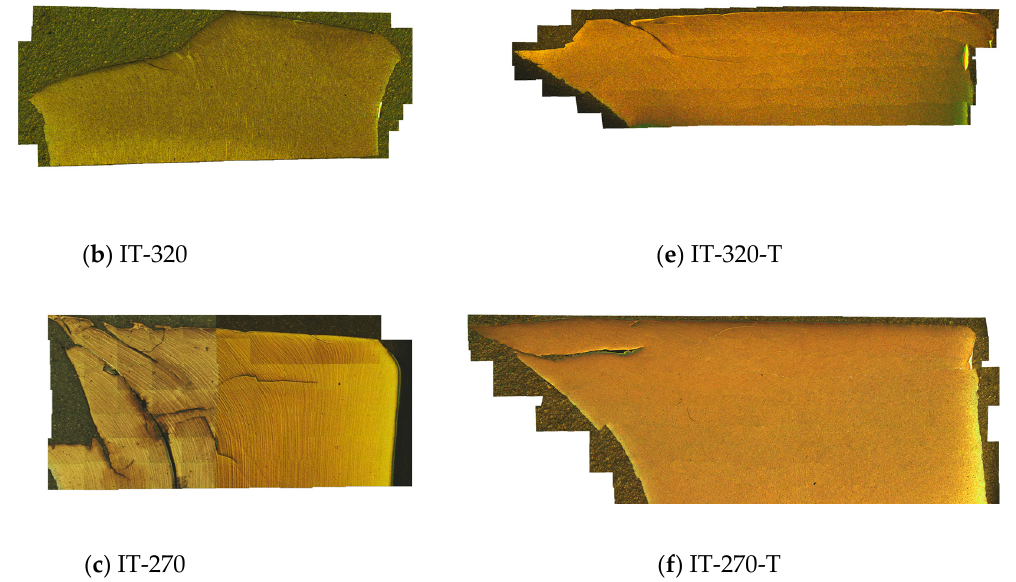
Figure 9. Optical microscope images of the cross-sections of the perforations: ( a ) IT-360, ( b ) IT-320, ( c ) IT-320, ( d ) RHA, ( e ) IT-320-T, and ( f ) IT-320-T.